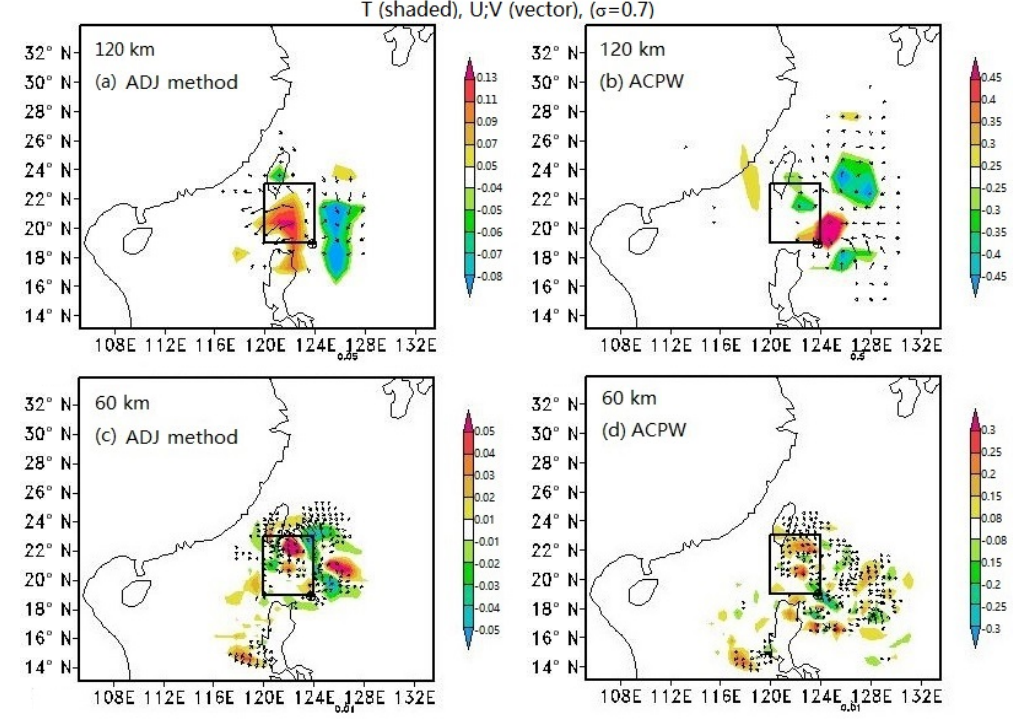
Figure 6. As described in Fig. 5 for tropical storm Matmo.